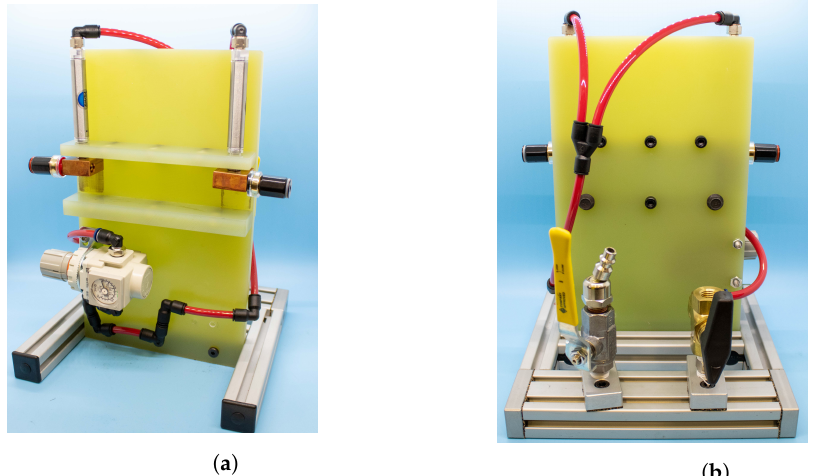
Figure 9. Fixture used to apply current to specimens; ( a ) front view, ( b ) back